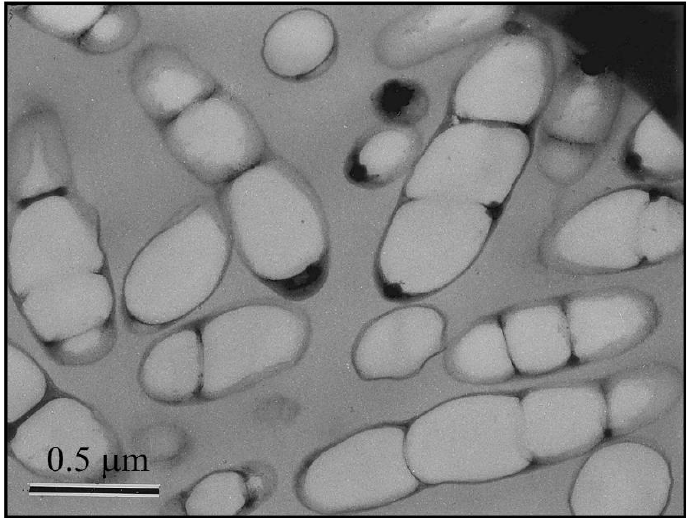
Figure 1. Transmission electron micrograph of thin sections of recombinant Ralstonia eutropha cells with polyhydroxyalkanoate (PHA) incrustations. Reproduced with permission from Ref. [9] .